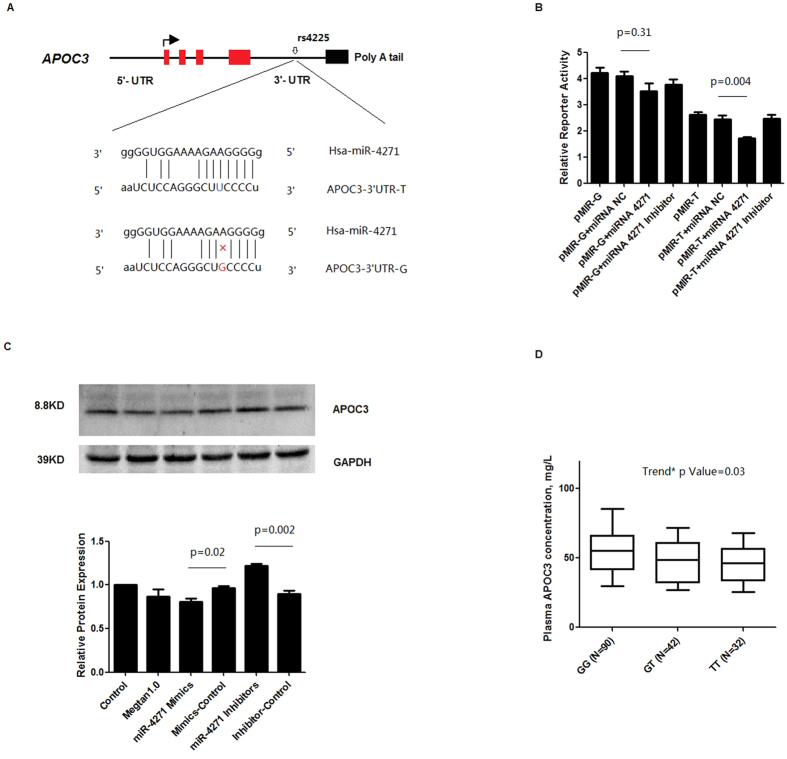
Functional validation of the miR-4271 binding site in the APOC3 3′UTR and the influence of the SNP rs4225.(A) APOC3 gene structure and the rs4225 polymorphism in the 3′ UTR at the miR-4271-binding site. The polymorphism rs4225 is a G to T change (mRNA sequence as reference) located in the predicted binding site for miR-4271 in the 3′-UTR of the APOC3 gene. At rs4225, allele T base-paired with U in Watson–Crick mode (shown with a solid line), whereas allele G did not (shown without line). (B) The interaction between miR-4271 and APOC3 using a reporter gene assay in HepG2 cells. Luciferase plasmid contains pMIR-T or pMIR-G was cotransfected with negative control miRNA (miR-NC) or miR-4271. For each transfection, at least six replicate assays were performed. Luciferase activity was normalized by Renilla luciferase activity for each sample. (C) miR-4271 negatively regulates APOC3 through binding to 3′-UTR of the APOC3. Inhibiting the expression of hsa-miR-4271 increased APOC3 expression in HepG2 cells analyzed by western blotting. Columns, mean of three independent experiments; bars, SE. (D) The plasma levels of APOC3 with different genotypes of the polymorphism rs4225. Individuals with TT genotype have lower plasma APOC3 levels vs. GG genotypes (p for trend = 0.03), and the data are presented as box (25th percentile, median and 75th percentile) and whisker (10th and 90th percentiles) plots.